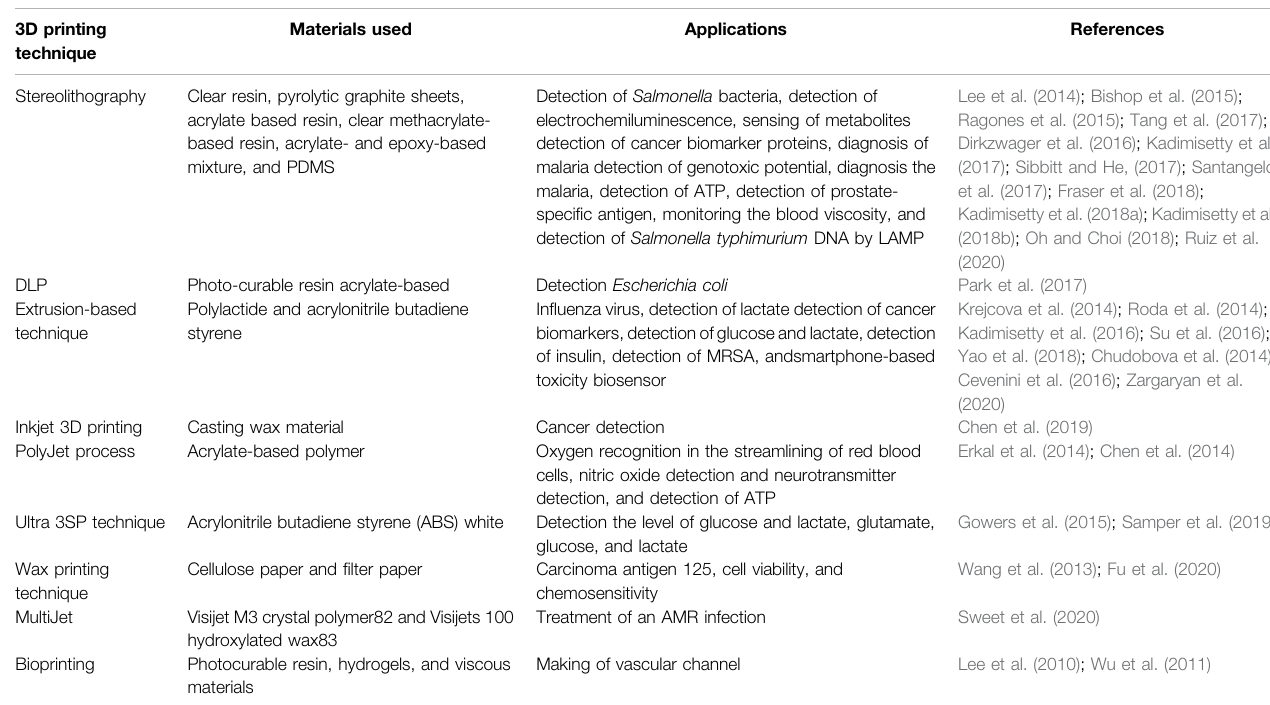
TABLE 2 | Summary of 3D printing technique used in biomedical